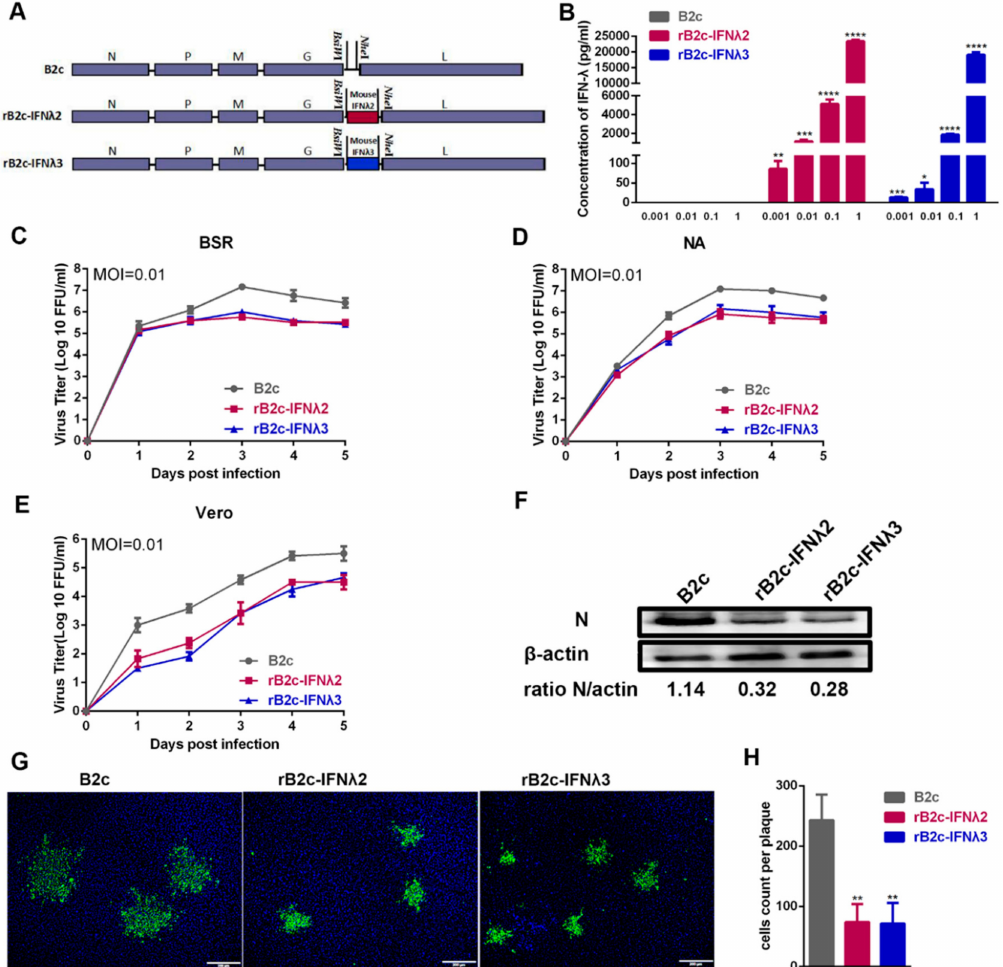
Figure 2. Construction and characterization of recombinant RABVs expressing IFN- λ 2 or IFN- λ 3. ( A ) Schematic diagram describing the construction of B2c, rB2c-IFN λ 2, and rB2c-IFN λ 3. The pcDNA3.1-B2c plasmid was derived from CVS-B2c by deleting the long non-coding region of the G gene and adding BsiW I and Nhe I sites between the G and L genes. Murine IFN- λ 2 or IFN- λ 3 coding sequences were then inserted into the RABV genome between the G and L genes. ( B ) Expression of IFN- λ 2 and IFN- λ 3 was measured by by ELISA. Briefly, NA cells were infected with B2c, rB2c-IFN λ 2, or rB2c-IFN λ 3 (MOI = 1, 0.1, 0.01, or 0.001) for 24 h, and the cell culture supernatants were then harvested to determine the quantity of murine IFN- λ 2 or IFN- λ 3 using a commercial ELISA kit. ( C ) BSR, NA ( D ), or Vero cells ( E ) were infected with di ff erent rRABVs at a MOI of 0.01, and multiple-step growth curves were depicted according to the viral titers at di ff erent time points. Error bars represent the SE ( n = 3). ( F ) RABV N protein expression in NA cells after infection with rRABVs. N protein was detected by western blot at 48 hpi and ratios of N / β -actin were calculated using ImageJ. ( G ) Comparison of the fluorescence morphologies of NA cells infected by di ff erent rRABVs at 48 hpi. Twenty fluorescent foci were examined to determine the number of infected cells per fluorescent focus ( H ). Scale bars represent 200 µ m. Error bars represented the SE ( n = 3). The following notations were used to indicate significant di ff erences between groups: *, p < 0.05; **, p < 0.01; ***, p < 0.001; ****, p <